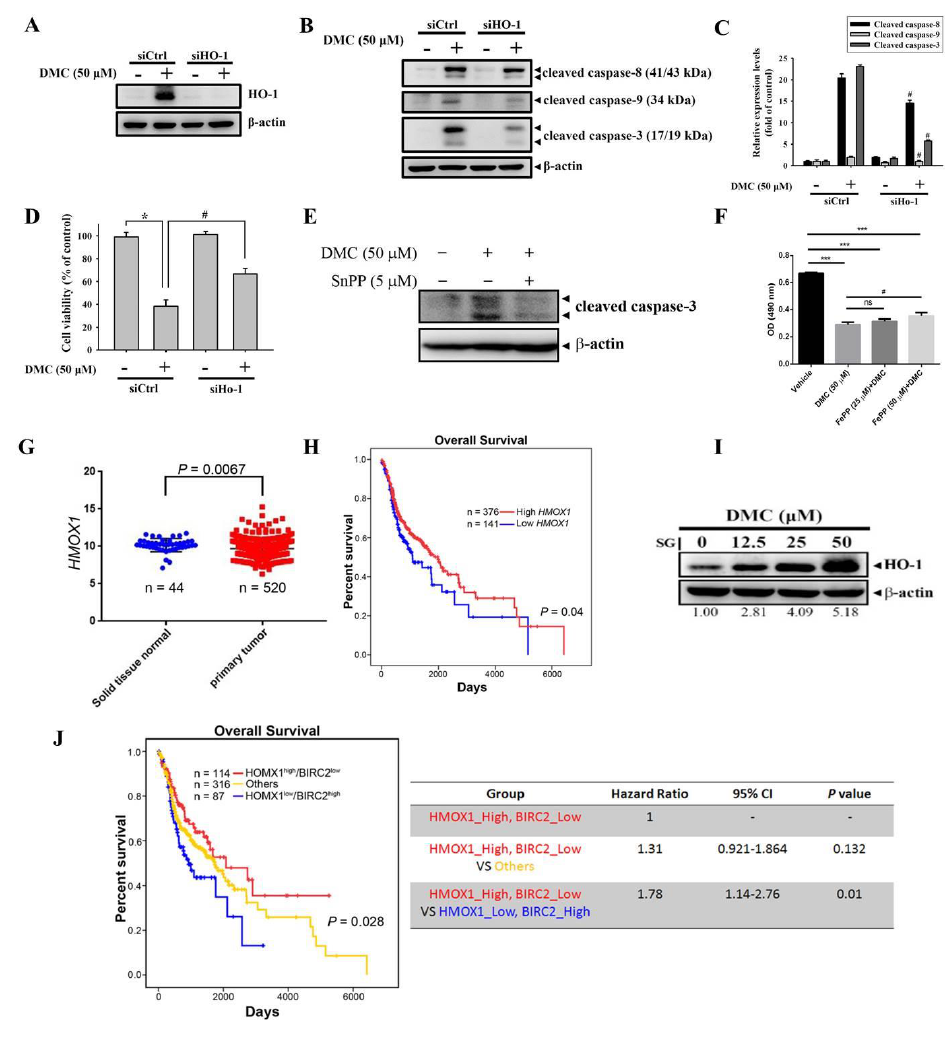
Figure 4. Heme oxygenase (HO)-1 is an upstream regulator involved in demethoxycurcumin (DMC)-induced caspase activation and the subsequent induction of apoptosis in oral squamous cell carcinoma (OSCC) cells. ( A – D ) HSC-3 cells were transiently transfected with HO-1-specific siRNA or control siRNA (siCtrl) and subjected to Western blot and MTT assays. The knockdown efficiency of HO-1 siRNA is shown in A. HO-1-specific siRNA reversed the DMC-induced increases in cleaved caspases-3, -8, and -9 ( B , C ) and the decrease of cell proliferation ( D ) of HSC-3 cells. Data are presented as the mean ± SD of three independent experiments. * p < 0.05, compared to the vehicle group; # p < 0.05, compared to the siCtrl-transfected group. ( E ) Enzyme activity of HO-1 is essential for the pro-apoptotic effect of DMC in OSCC cells. SCC-9 cells were treated with DMC in the presence or absence of the HO-1 enzymatic inhibitor, SnPP (5 µ M), for 24 h, and the expression of cleaved caspase-3 was analyzed by an Western blotting analysis. ( F ) The effect of combined treatment with DMC and iron protoporphyrin IX (FePP) / heme on cell viability of OSCC cells. SCC-9 cells were treated with DMC (50 µ M) simultaneously with or without FePP (25 or 50 µ M) for 24 h and then subjected to MTS assay to determine the cell viability. Columns, mean ( n = 3); bars, SD. *** p < 0.001 compared with the vehicle group. # p < 0.05 compared with the DMC-treated only group. ns: not significant. ( G ) Expressions of mRNA levels of HMOX1 (FPKM) in normal tissues ( n = 44) and primary head–neck tumors ( n = 520). ( H ) Correlation of HMOX1 expression and overall survival (OS) in head–neck squamous cell carcinoma using an Kaplan–Meier analysis. ( I ) SG cells were treated with indicated concentrations of DMC for 24 h, and an Western